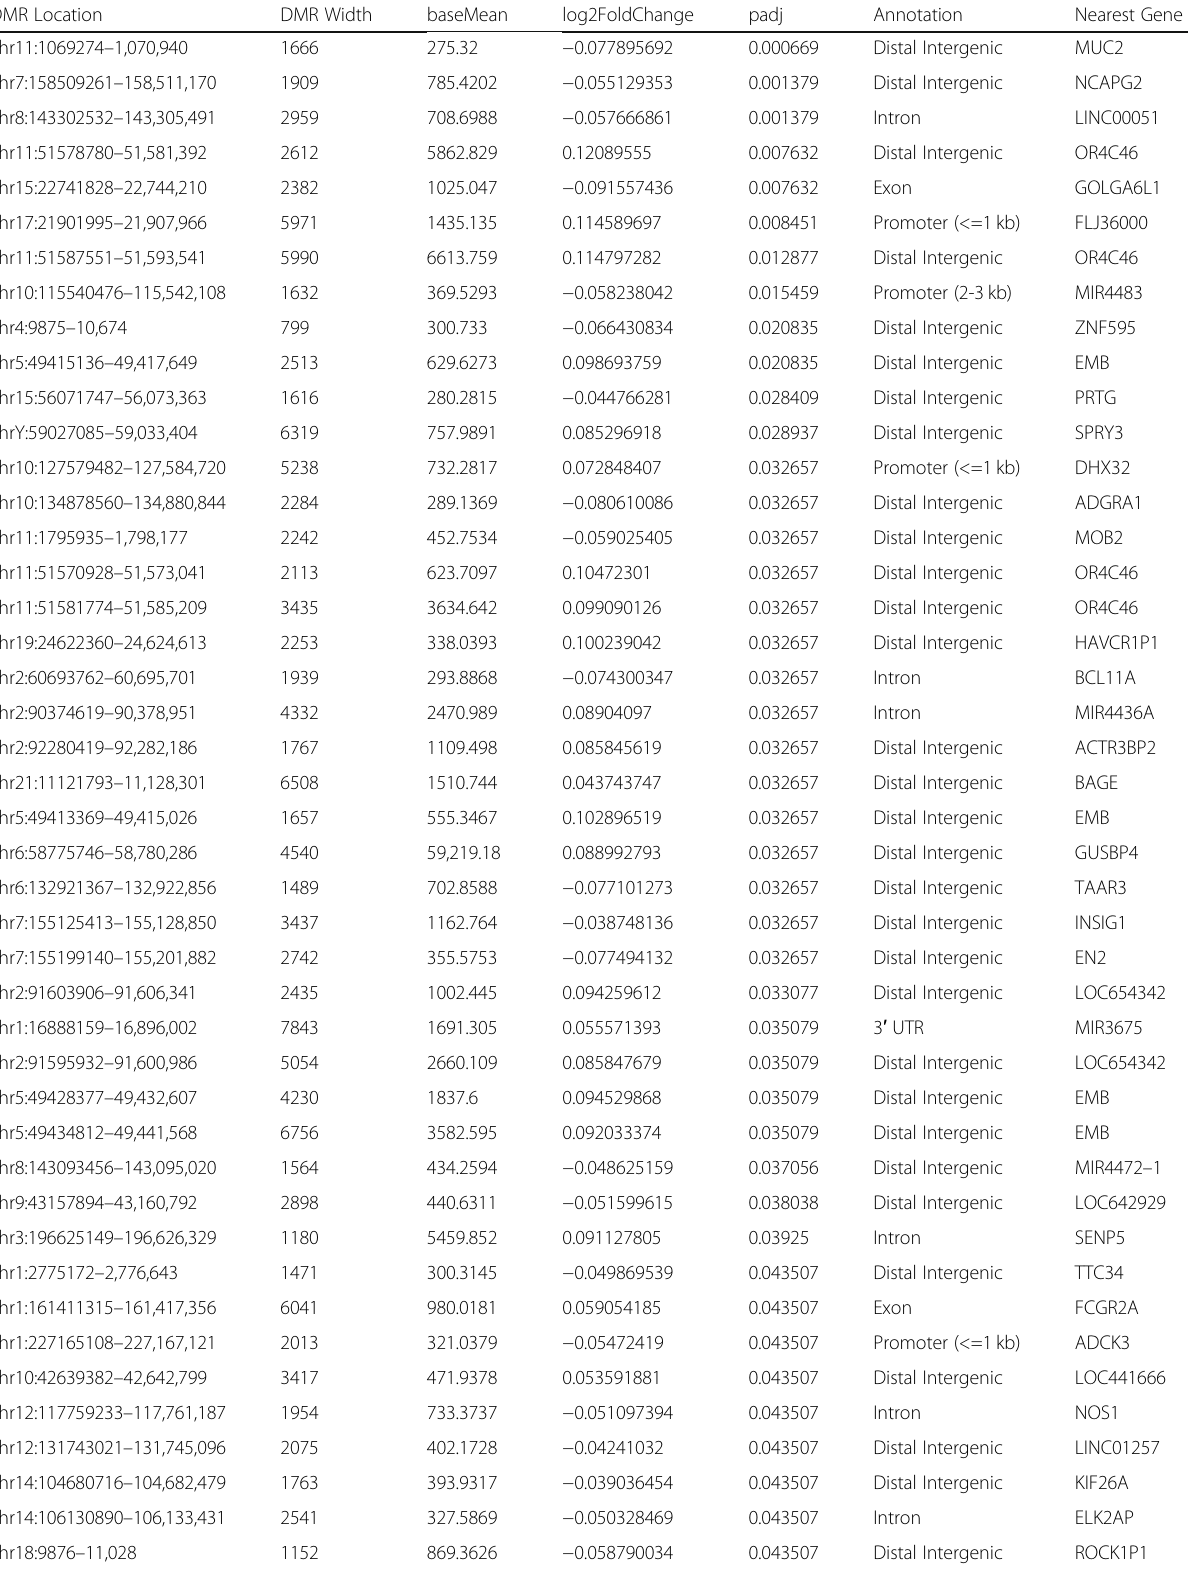
Table 3 Annotated DMR ’ s Associated with Gestational